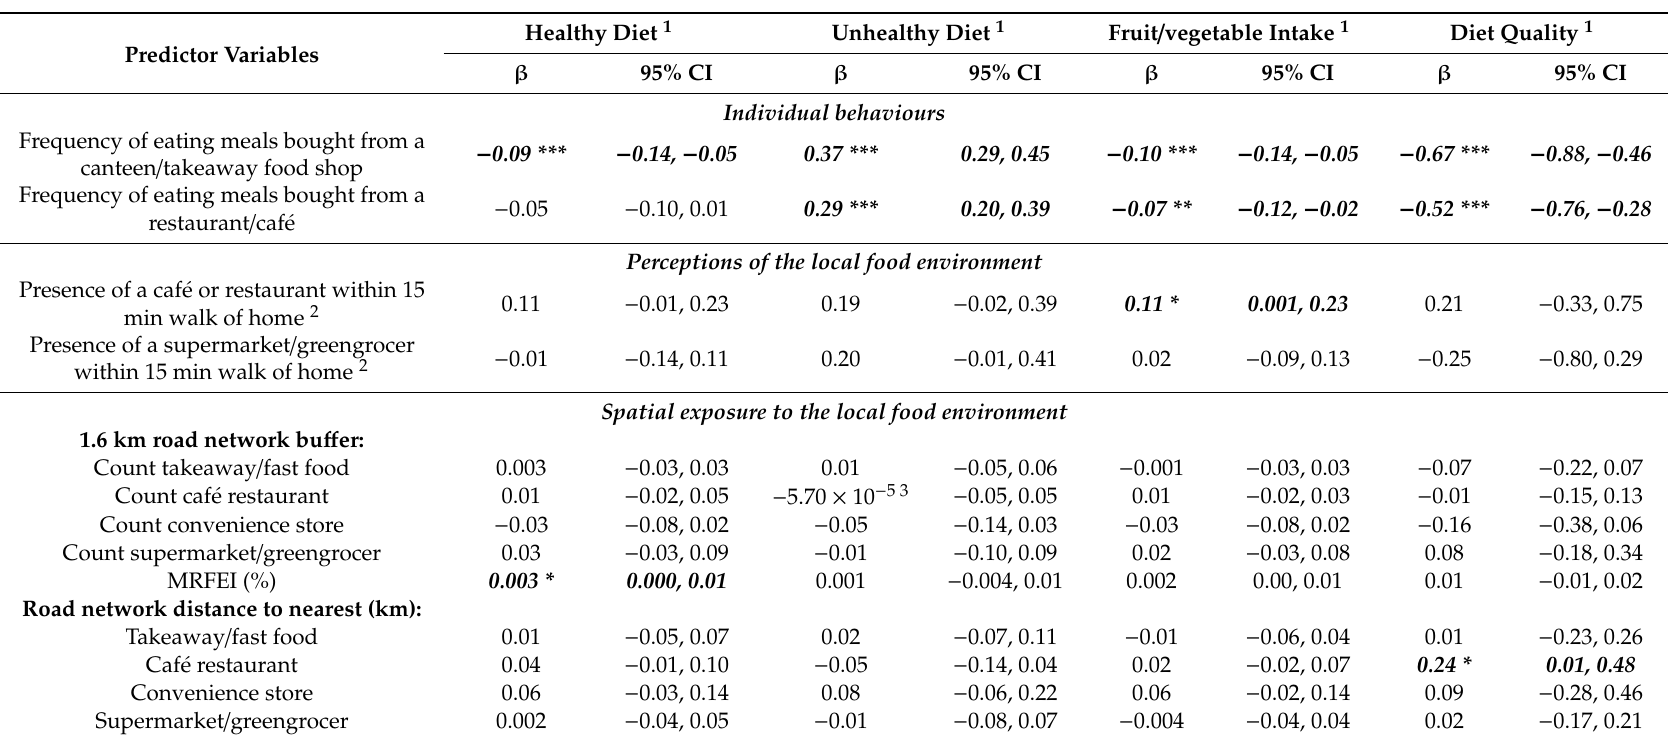
Table 3. Single factor associations between changes in predictor variables and changes in dietary outcomes.